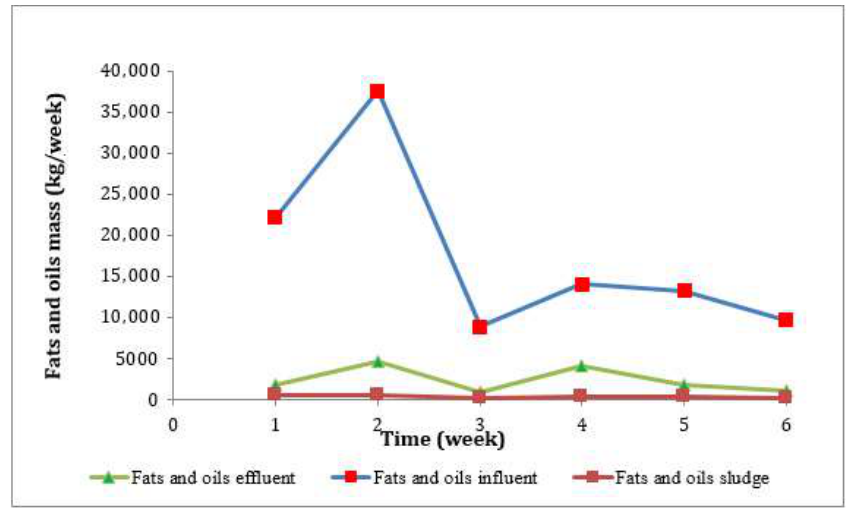
Figure 6. Weekly changes in mass of fats and oils in real scale wastewater treatment plant.